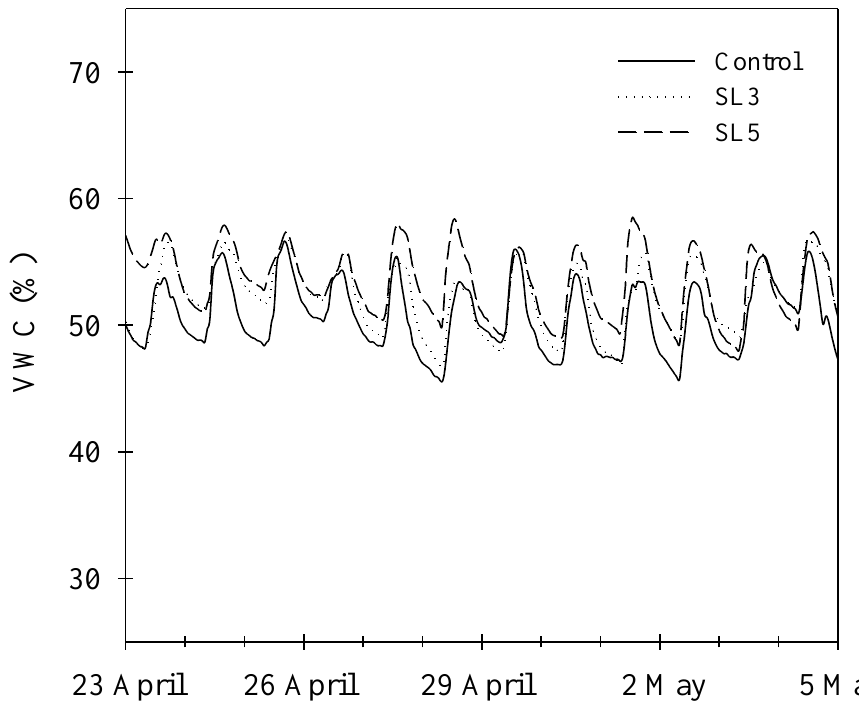
Figure 2. Example of volumetric water content (VWC) values for the three treatments. Lines represent three different irrigation water ECs: control (solid line, 1.8 dS m − 1 ), SL3 (dotted line, 3.3 dS m − 1 ), and SL5 (dashed line, 4.9 dS m − 1 ). The peaks correspond to the maximum moisture, just after an irrigation event, while the valleys indicate the beginning of an irrigation event.